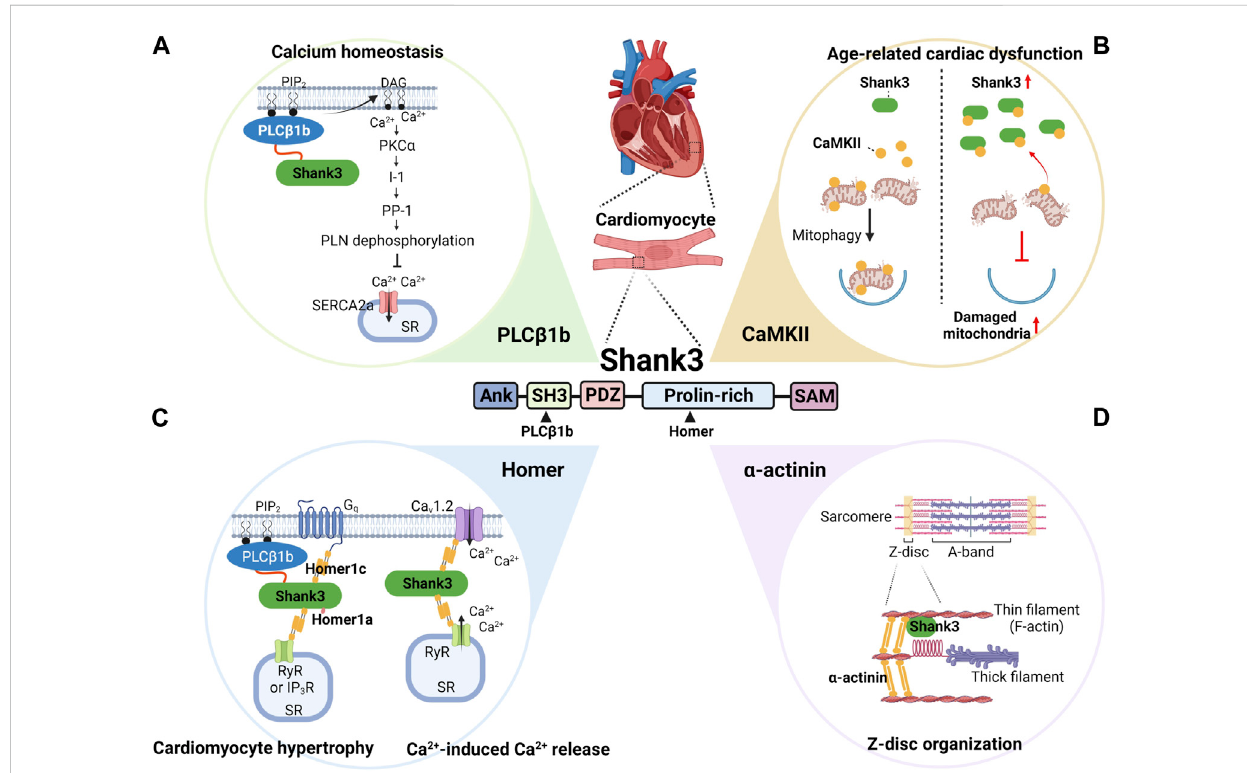
FIGURE 2 Summary of the demonstrated and predicted roles of Shank3 in cardiac function and dysfunction. In cardiomyocytes, Shank3 interacts with several proteins, including PLC β 1b (A) , CaMKII (B) , Homer (C) , and α -actinin (D) . Speci fi cally, PLC β 1b and Homer bind to the SH3 and proline-rich domains of Shank3, respectively. By regulating the subcellular localization and activity of these interactors, Shank3 plays important roles in various physiological and pathological molecular pathways. These pathways include calcium homeostasis (A) , age-related cardiac dysfunction (B) , cardiomyocyte hypertrophy and calcium-induced calcium release (C) , and Z-disc organization (D) . ANK, ankyrin repeats; CaMKII, calcium-calmodulin-dependent protein kinase II; DAG, diacylglycerol; I-1, inhibitor-1; IP 3 R, inositol 1,4,5-triphosphate receptor; PDZ, PSD-95, Dlg, and Zo-1; PIP 2 , phosphatidylinositol 4,5-bisphosphate; PKC α , protein kinase C α ; PLC β 1b, phospholipase C β 1b; PLN, phospholamban; PP-1, protein phosphatase-1; RyR, ryanodine receptor; SAM, sterile alpha motif; SERCA2a, sarco-endoplasmic reticulum ATPase 2a; SH3, Src homology 3; SR, sarcoplasmic reticulum. The fi gure was created with